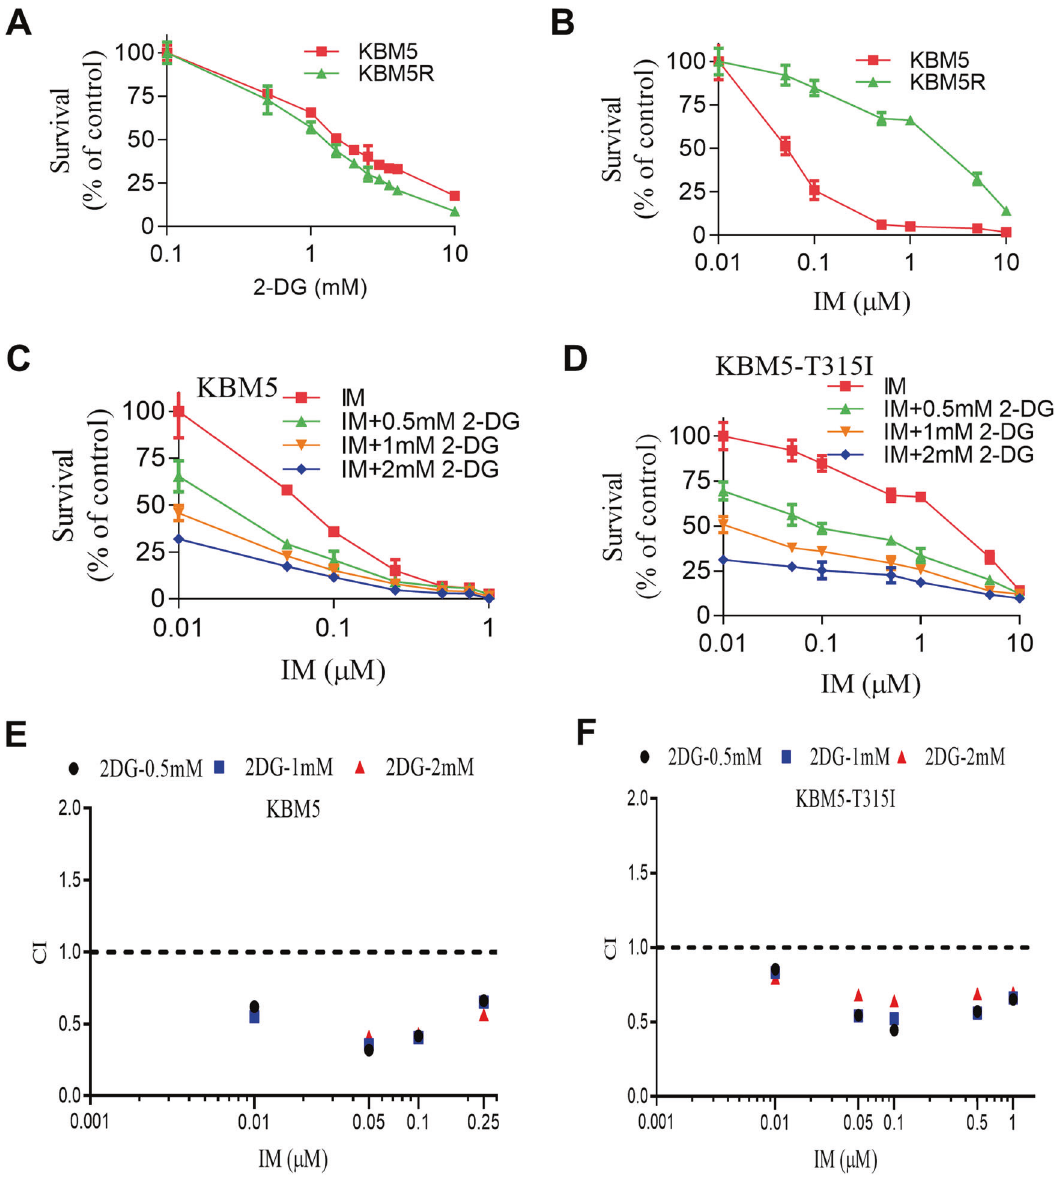
viability was measured by a CCK-8 assay. Data were mean ± SD ( n = 3). C , D Dose-response curves of IM with or without 0.5, 1.0, 2.0 mM 2-DG for KBM5 and KBM5-T315I cells. Data were mean ± SD ( n = 3). E , F Combination index (CI) of 2-DG and IM in the indicated two cell line cells described in ( C , D ) was analyzed by using CalcuSyn software. CI > 1 indicates antagonist effect; CI = 1 indicates additive effect; CI < 1 indicates synergistic